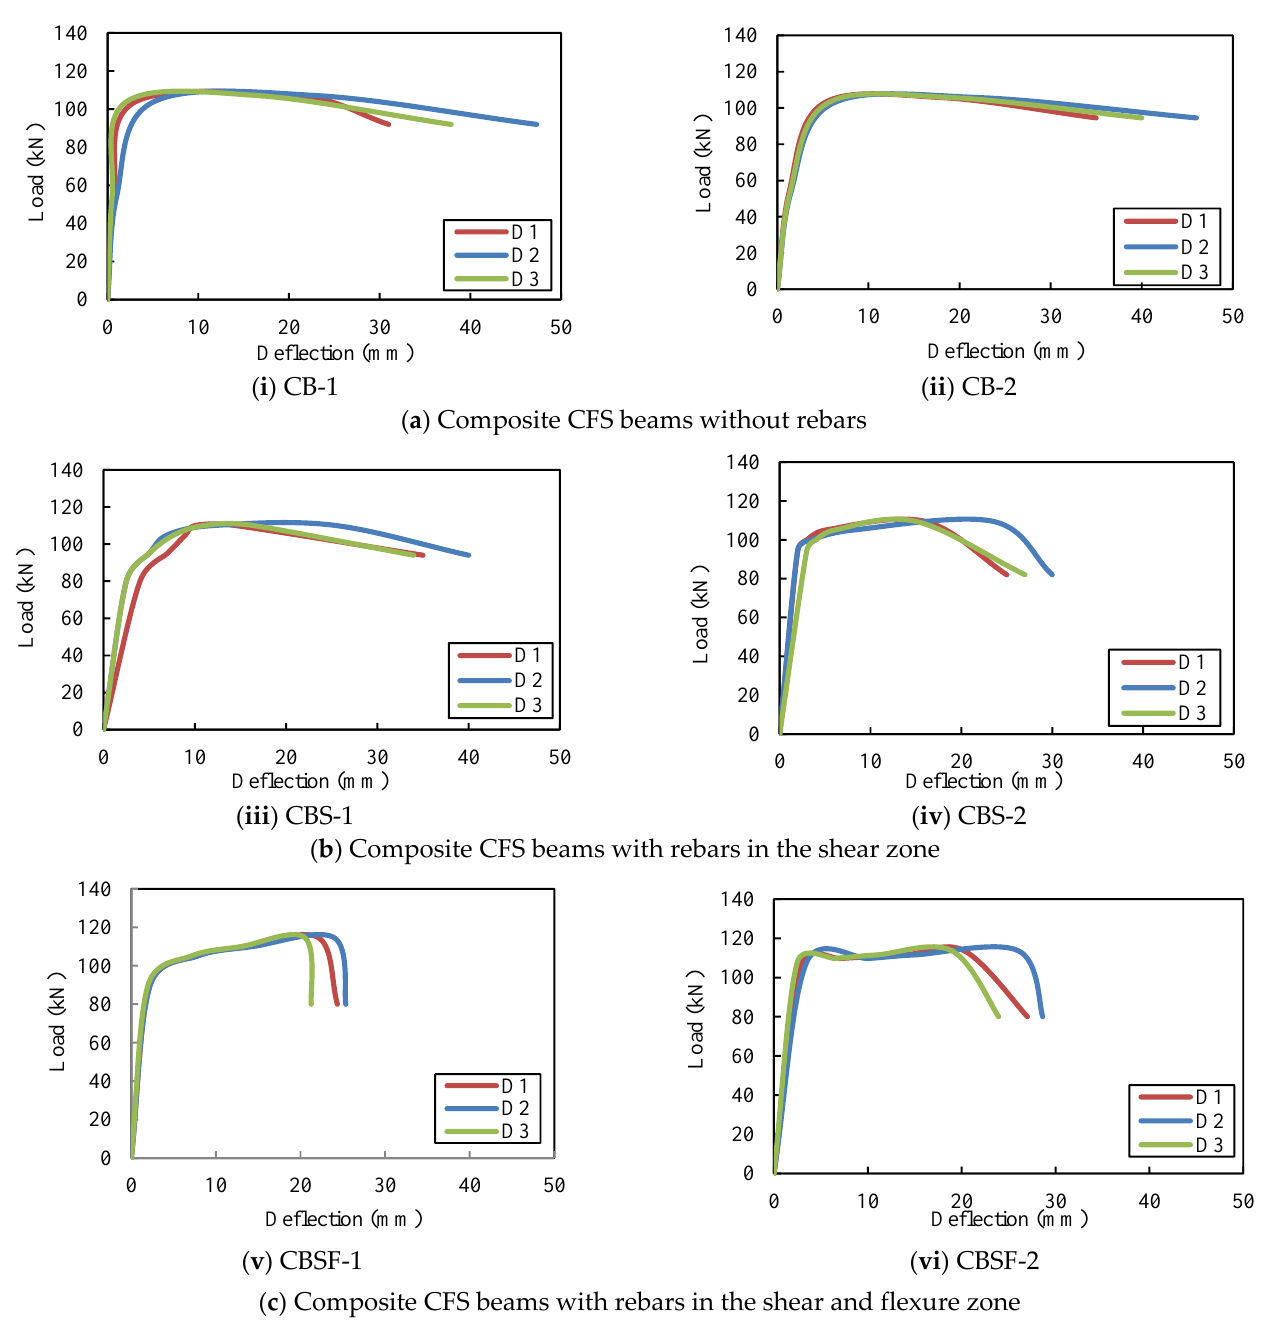
Figure 7. Load versus deflection curves of the composite CFS beams. The average ultimate loads for the plain CFS beams CB, CBS, and CBSF, respectively, were 106 kN, 110 kN, and 114 kN. Thus, the ultimate load-carrying capacity of the beams CBS and CBSF increased by 3% and 7%, respectively, when compared to the CB beams. The CBSF beam’s average ultimate load-carrying capacity was 2.7 times that of the PBSF beam. Figure 8 compares the load capacities of the CFS beams. As a result, CFS beams with fly ash concrete encased webs could be used to carry heavy loads in buildings while maintaining a low floor